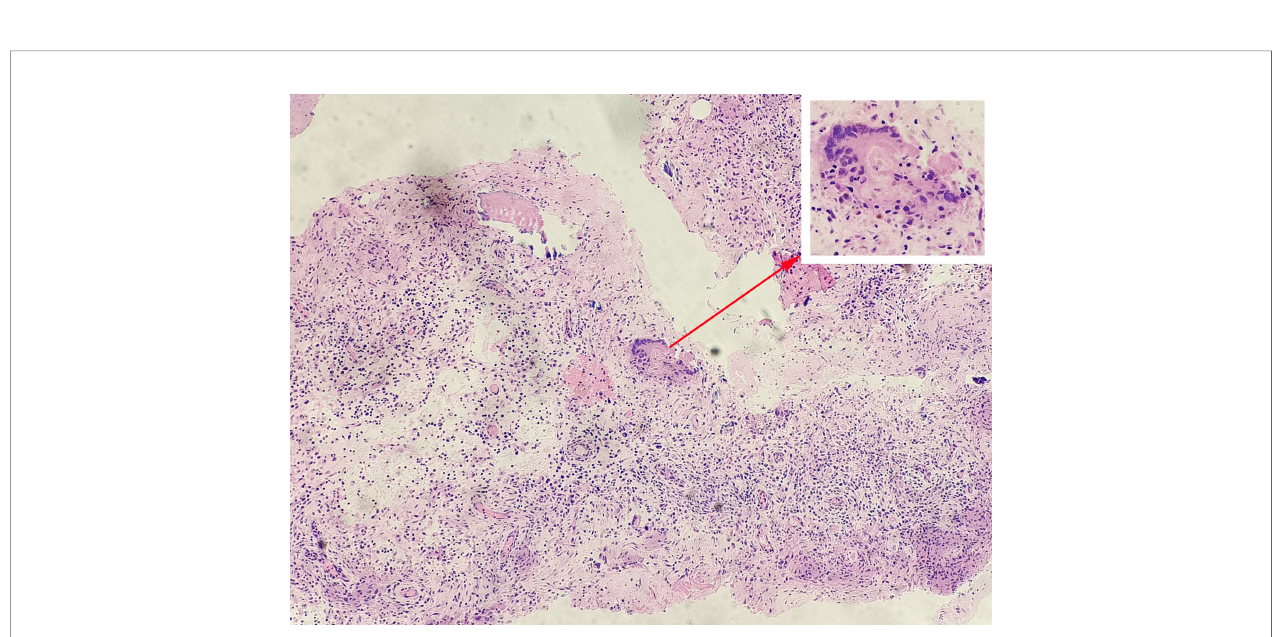
FIGURE 2 | Pathological examination of a patient with spinal tuberculosis. Tuberculosis granulomas were observed in tissue sections under a microscope and consisted mainly of dermoid cells, multinucleated giant cells, and lymphocytes. The arrow points to the tuberculosis granulomas and the Langerhans multinucleated giant